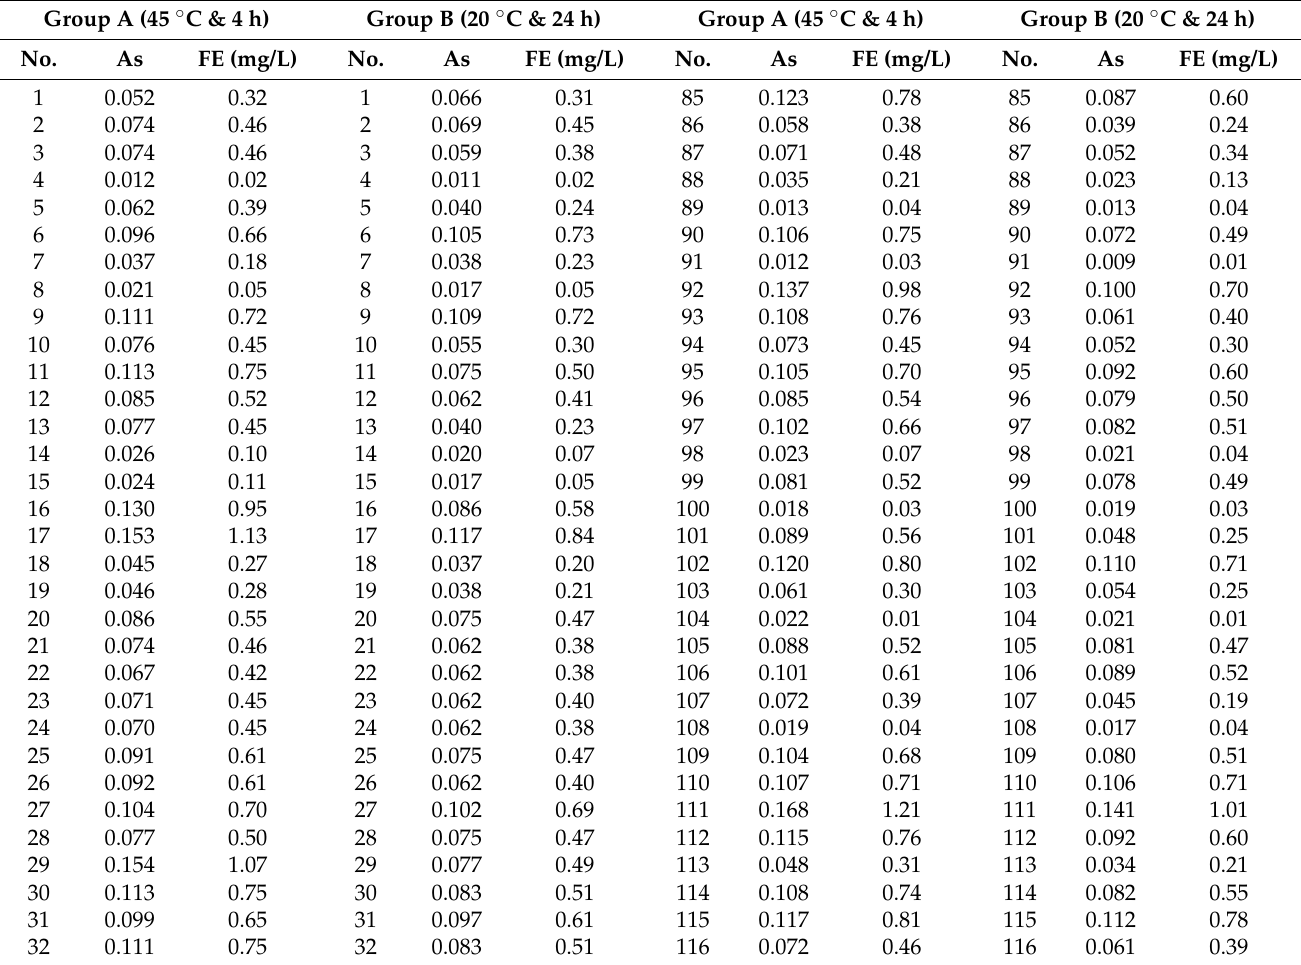
Table 6. Formaldehyde emissions data measured by the desiccator at 45 ◦ C for 4 h and 20 ◦ C for 24